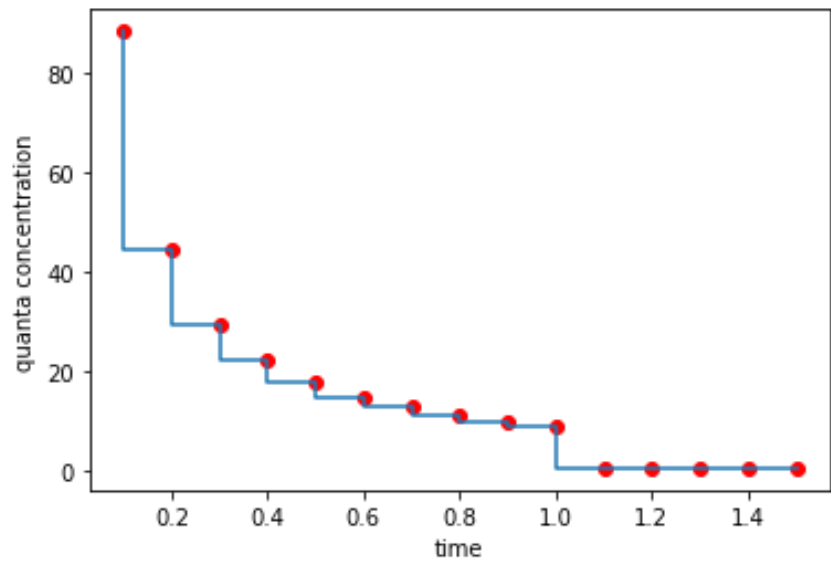
Figure 8. Quanta concentration of viral particles changes over time (first 1.5 s) after being released. Red points represent the instantaneous concentration at the end of each shorter interval.